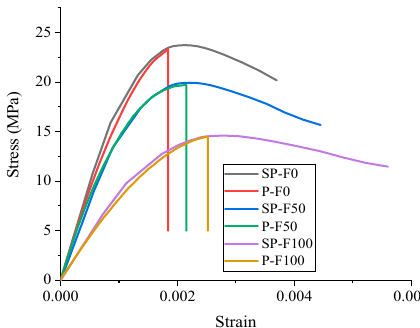
Figure 17. Comparison of compressive stress–strain curves of unreinforced specimens under freeze– thaw action.